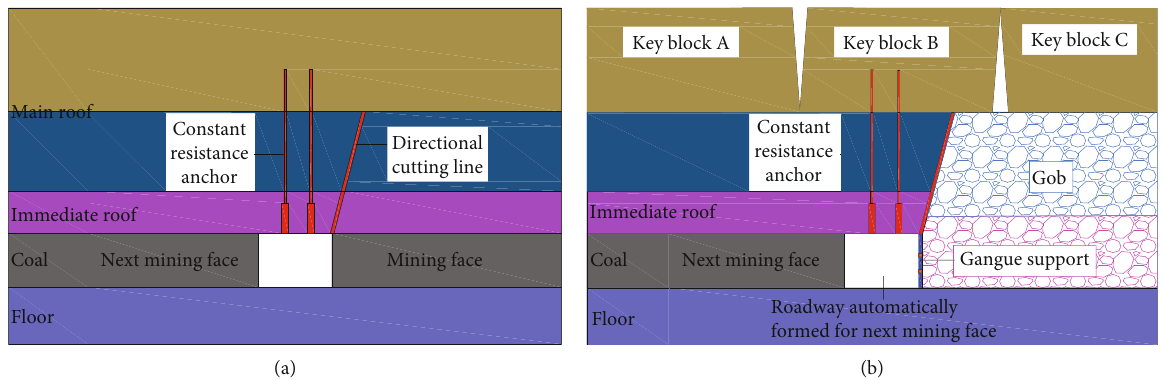
Figure 1: Schematic diagram of noncoal pillar mining with automatically formed roadway: (a) directional roof cutting and (b) roof collapses along the directional cutting line to form a roadway serving the next face.